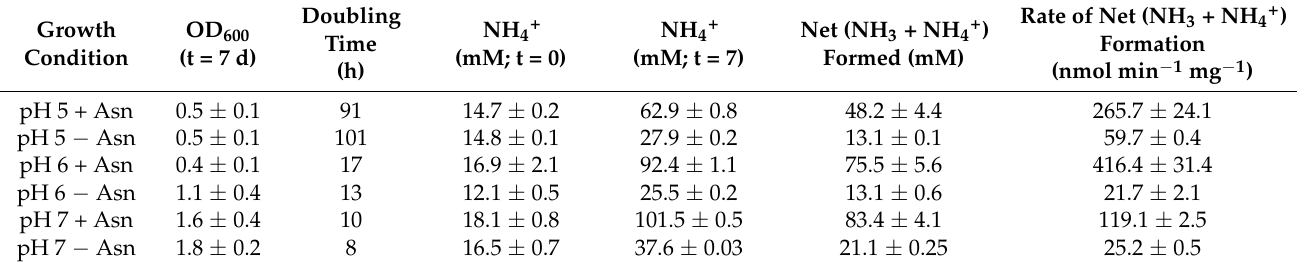
Table 1. Effect of pH and L-asparagine on the growth and formation of (NH 3 + NH 4+ ) by P. bivia . OD 600 and [NH 3 + NH 4+ ] were determined in the stationary phase (t = 7 d) of P. bivia cultures grown at pH 5, 6, or 7 with or without supplementation of 50 mM of L-asparagine.